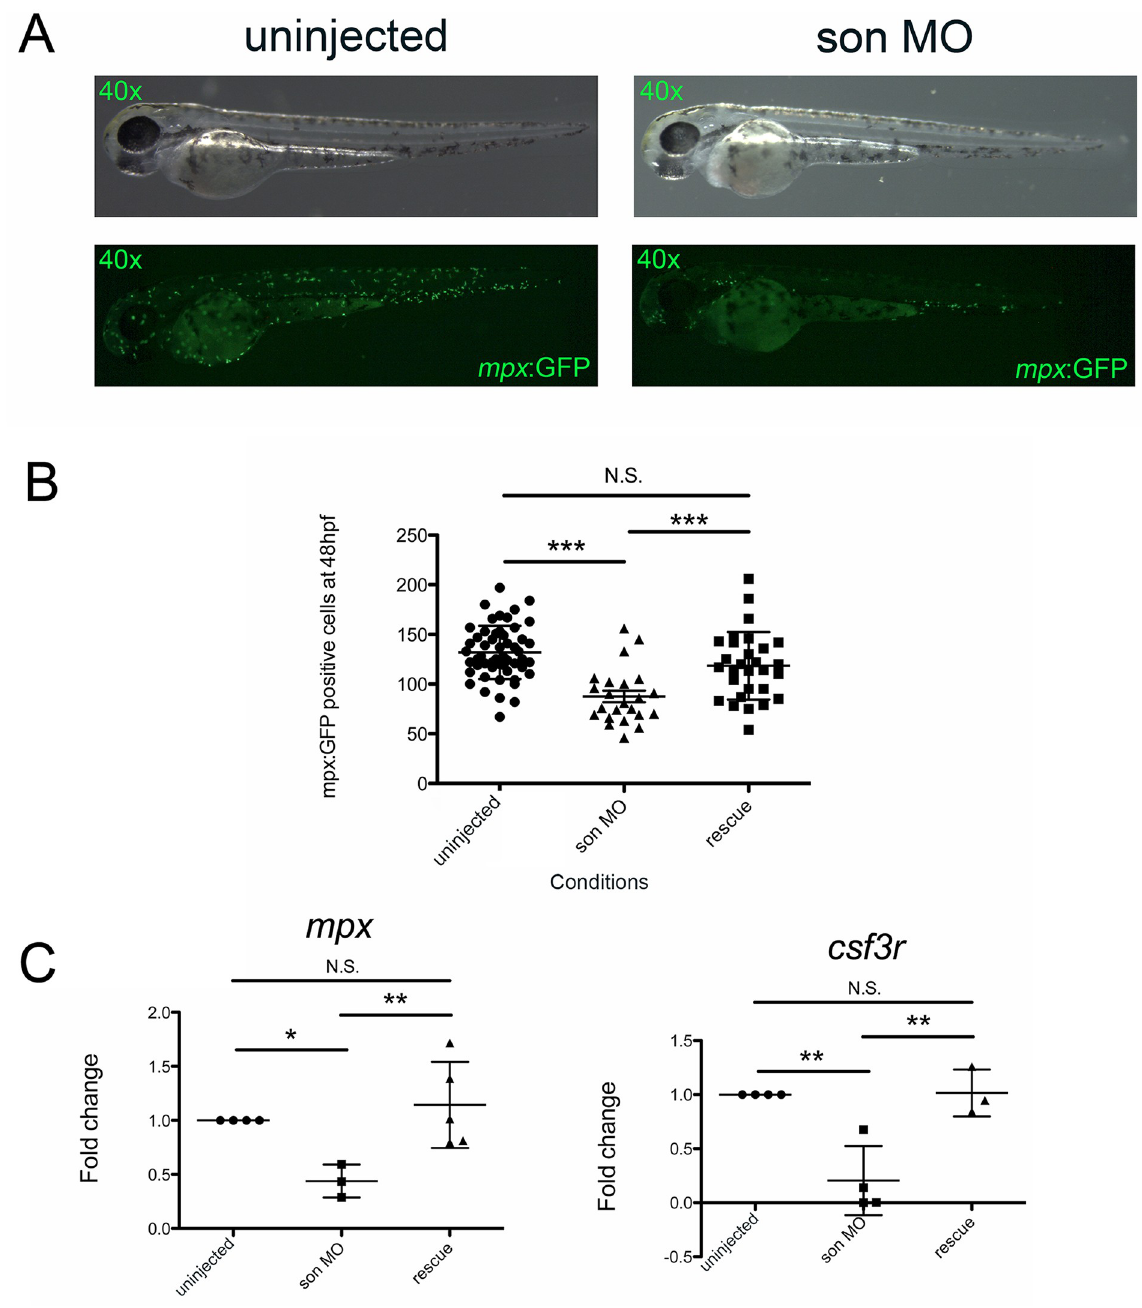
Fig 3. son knockdown causes a reduction in neutrophils. ( A ) Representative images of mpx :GFP embryos at 48hpf that were uninjected (left) or MO-injected ( son MO, right). Images are taken at 40x, and every green dot is a labelled neutrophil; these cells are in tissues and not circulating. ( B ) Each point represents the number of GFP+ myeloid cells present in an individual uninjected, MO-injected ( son MO), or MO- injected with son RNA (rescue) embryo. Images were taken and GFP + cells were manually enumerated. Middle lines represent mean and error bars represent SD. ( C ) qRT-PCR for mpx (left) and csf3r (right) was performed. Each point represents ten embryos randomly selected from uninjected, MO-injected ( son MO), or MO-injected with son RNA (rescue) conditions that were analyzed by qRT-PCR. Middle lines represent mean and error bars represent SD. � represents p = 0.02, �� represents p = 0.01, ��� represents p < 0.001, N.S. represents no significance.